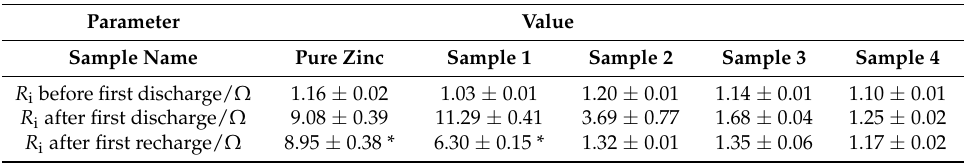
Table 3. Internal resistances of electrochemically investigated zinc–glass composites before the first discharge, after the first discharge, and after the first recharge.